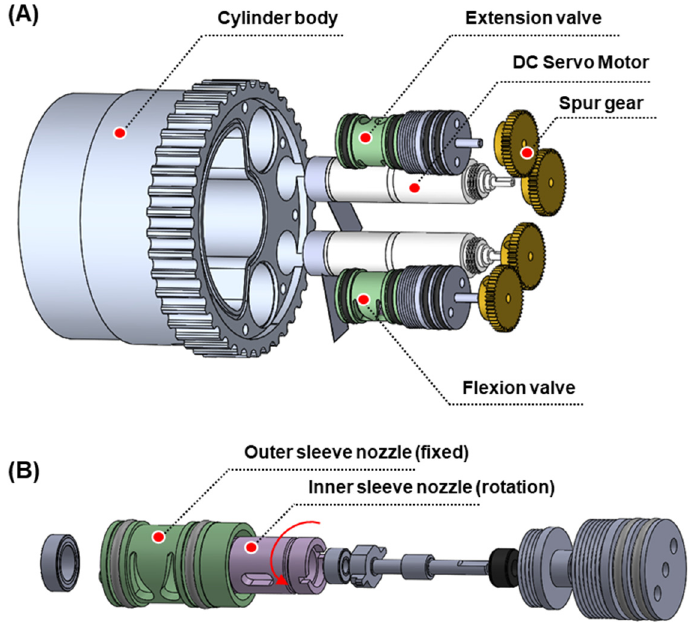
Figure 4. The shape of the rotary hydraulic nozzle: ( A ) composition of flexion/extension servo valve; ( B ) composition of the nozzle part. The outer nozzle is fixed, and the inner nozzle is rotated by the motor. Fluid flows through an intersection of the slots of the inner and outer nozzles.